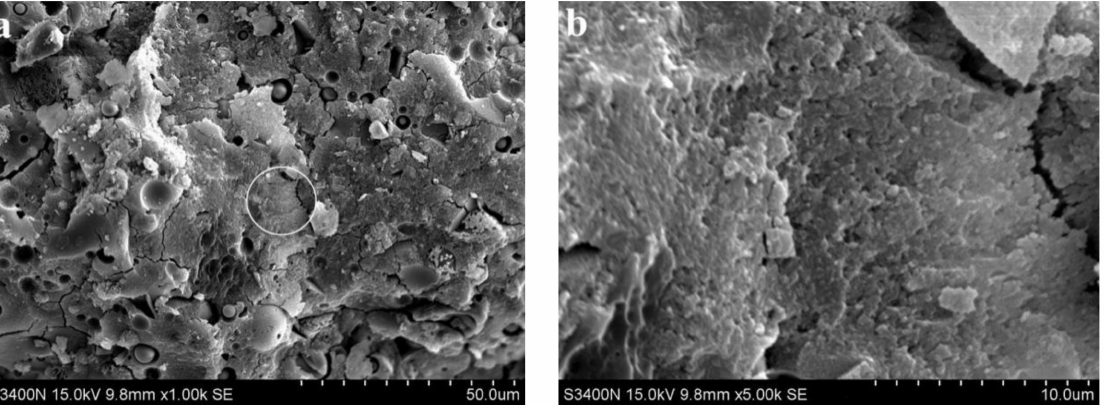
Figure 13. SEM images of alkali slag cement sand replaced by 80% ore powder with fly ash at hydration ages of 28 d. ( a ) × 1.00 k, ( b ) × 5.00